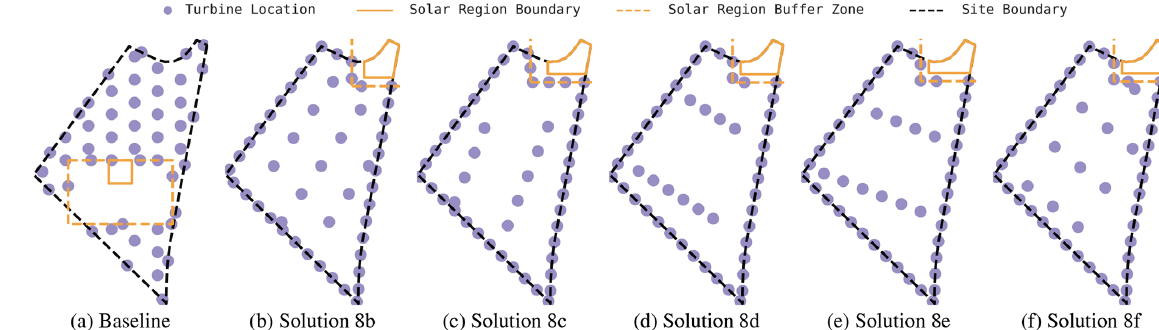
Figure 9. CMA-ES solutions for the low-correlation location and irregular boundary. Table 4. CMA-ES layout performance statistics for each solution in Figs.